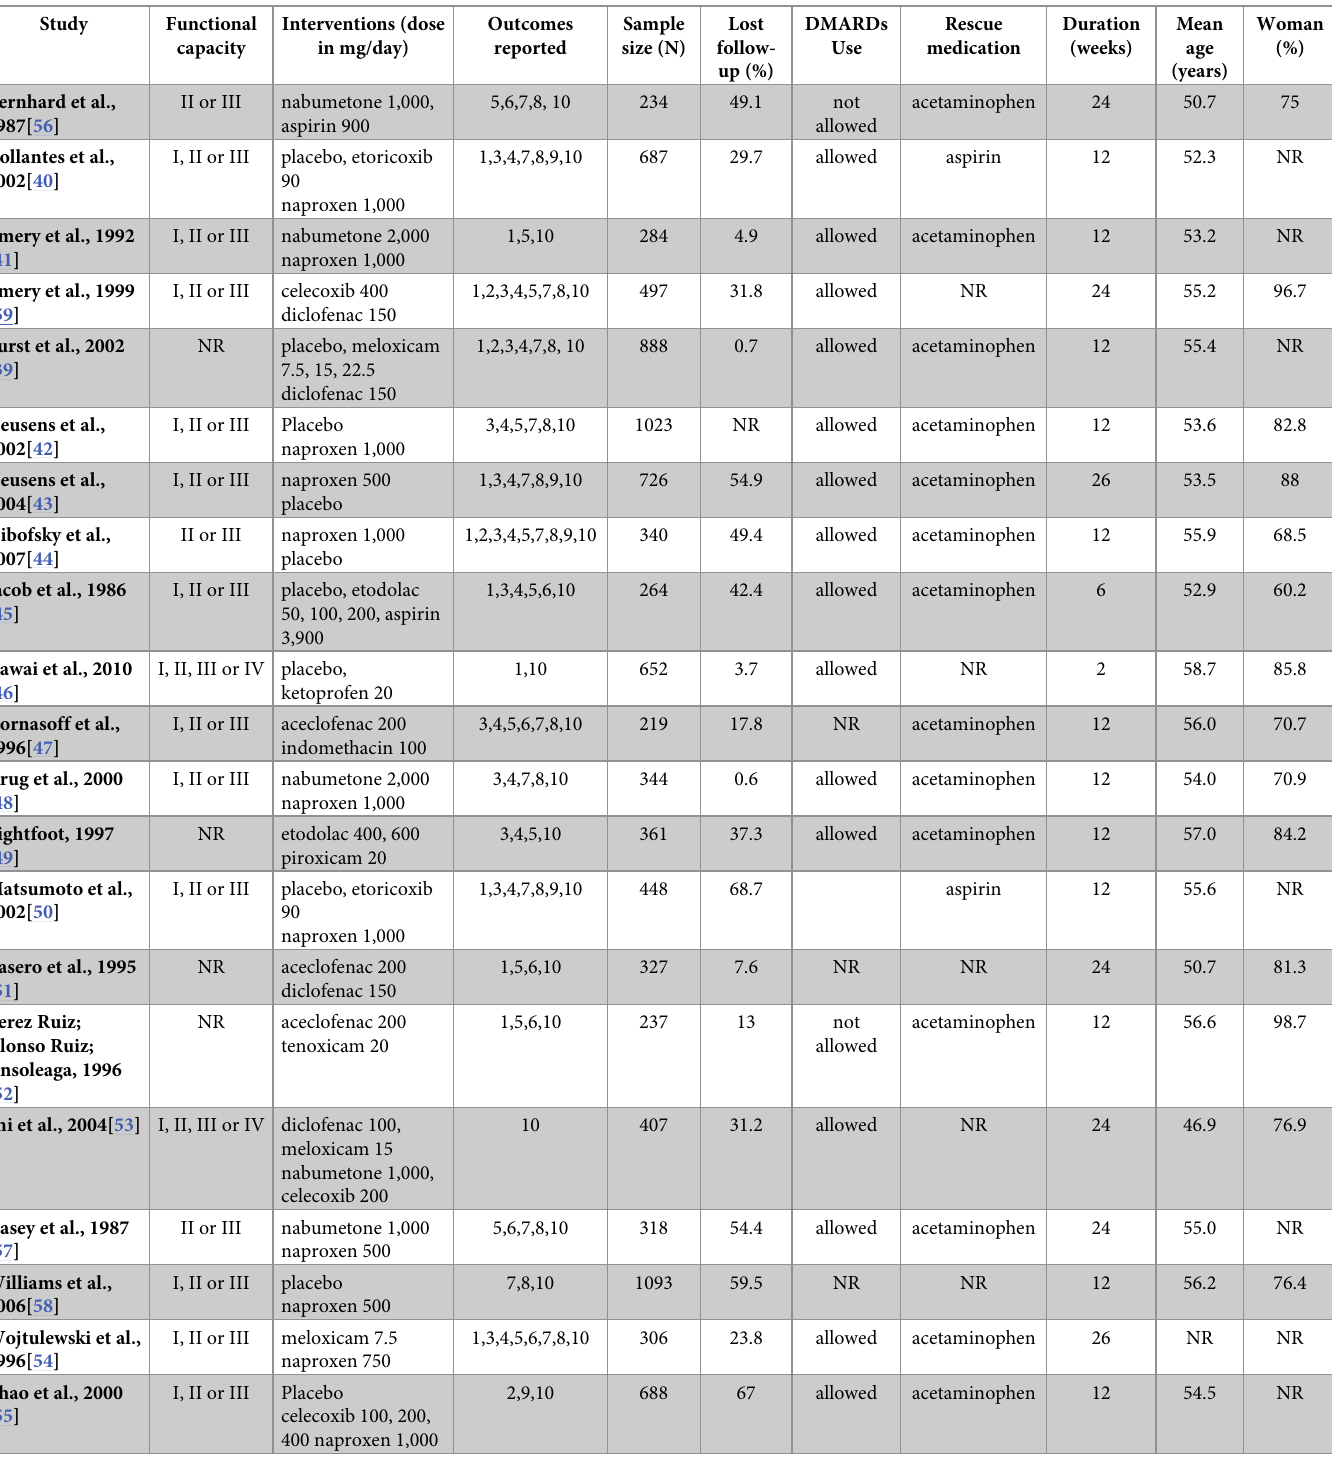
Table 1. Characteristics of the included studies on non-steroidal anti-inflammatories for rheumatoid arthritis (n = 21).